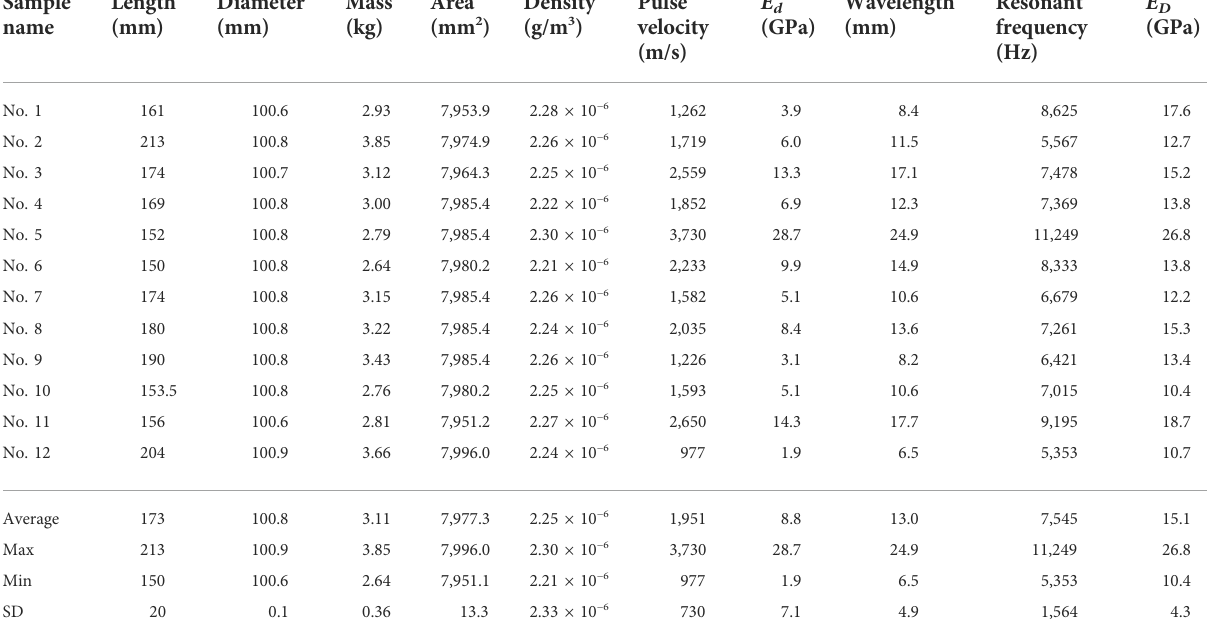
TABLE 3 Physical properties of testing concrete samples.